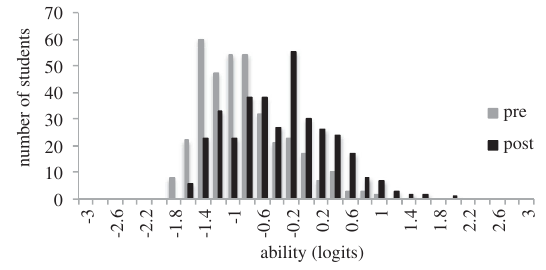
FIG. 7. The distribution of pre- and postinstruction abilities for the 363 students in low-IAS classes with at least 25